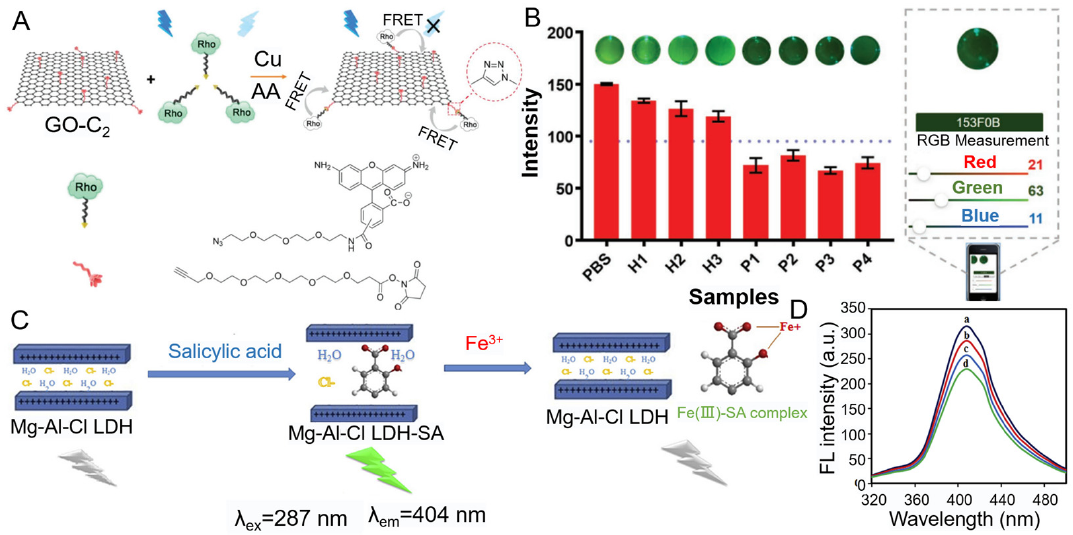
Figure 3. Two representative examples of essential metal ion detection in vitro: ( A ) Schematic illustration of the Cu 2+ detection system based on click chemistry and FRET between GO-C2 and Rho-N3. ( B ) Detection Cu in patient urine by reading the green value of the photo of the samples using the smartphone. Reproduced from [75] with permission from John Wiley and Sons, copyright 2018. ( C ) Schematic illustration of the Fe 3+ detection system based on nano-structured Mg-Al layered double hydroxide intercalated with salicylic acid (Mg-Al LDH–SA). ( D ) The fluorescence emission spectra of the deproteinized human serum sample before ( a ) and after adding a standard solution of Fe 3+ ( b – d ). Reproduced from [18] with permission from Elsevier, copyright